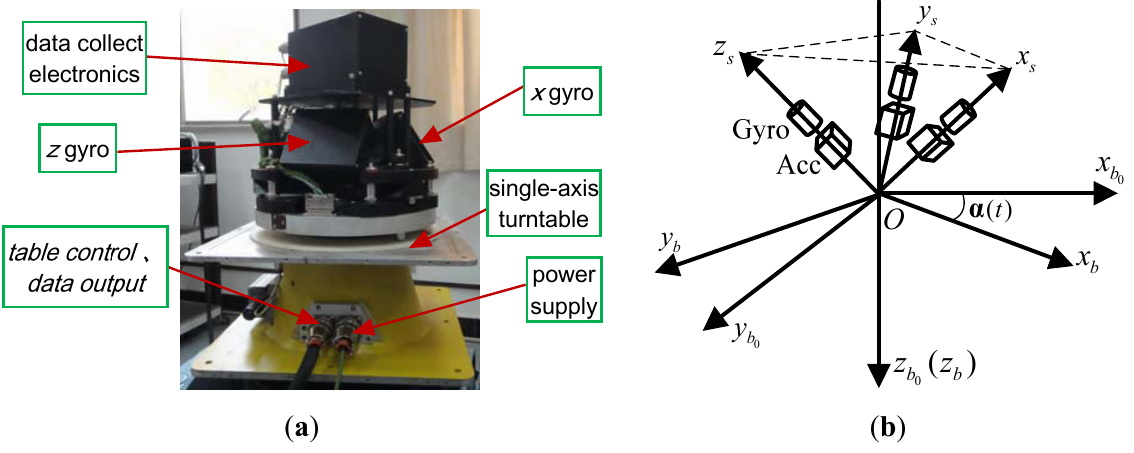
Figure 1. ( a ) The postulate system; ( b ) Coordinate frames in the postulate